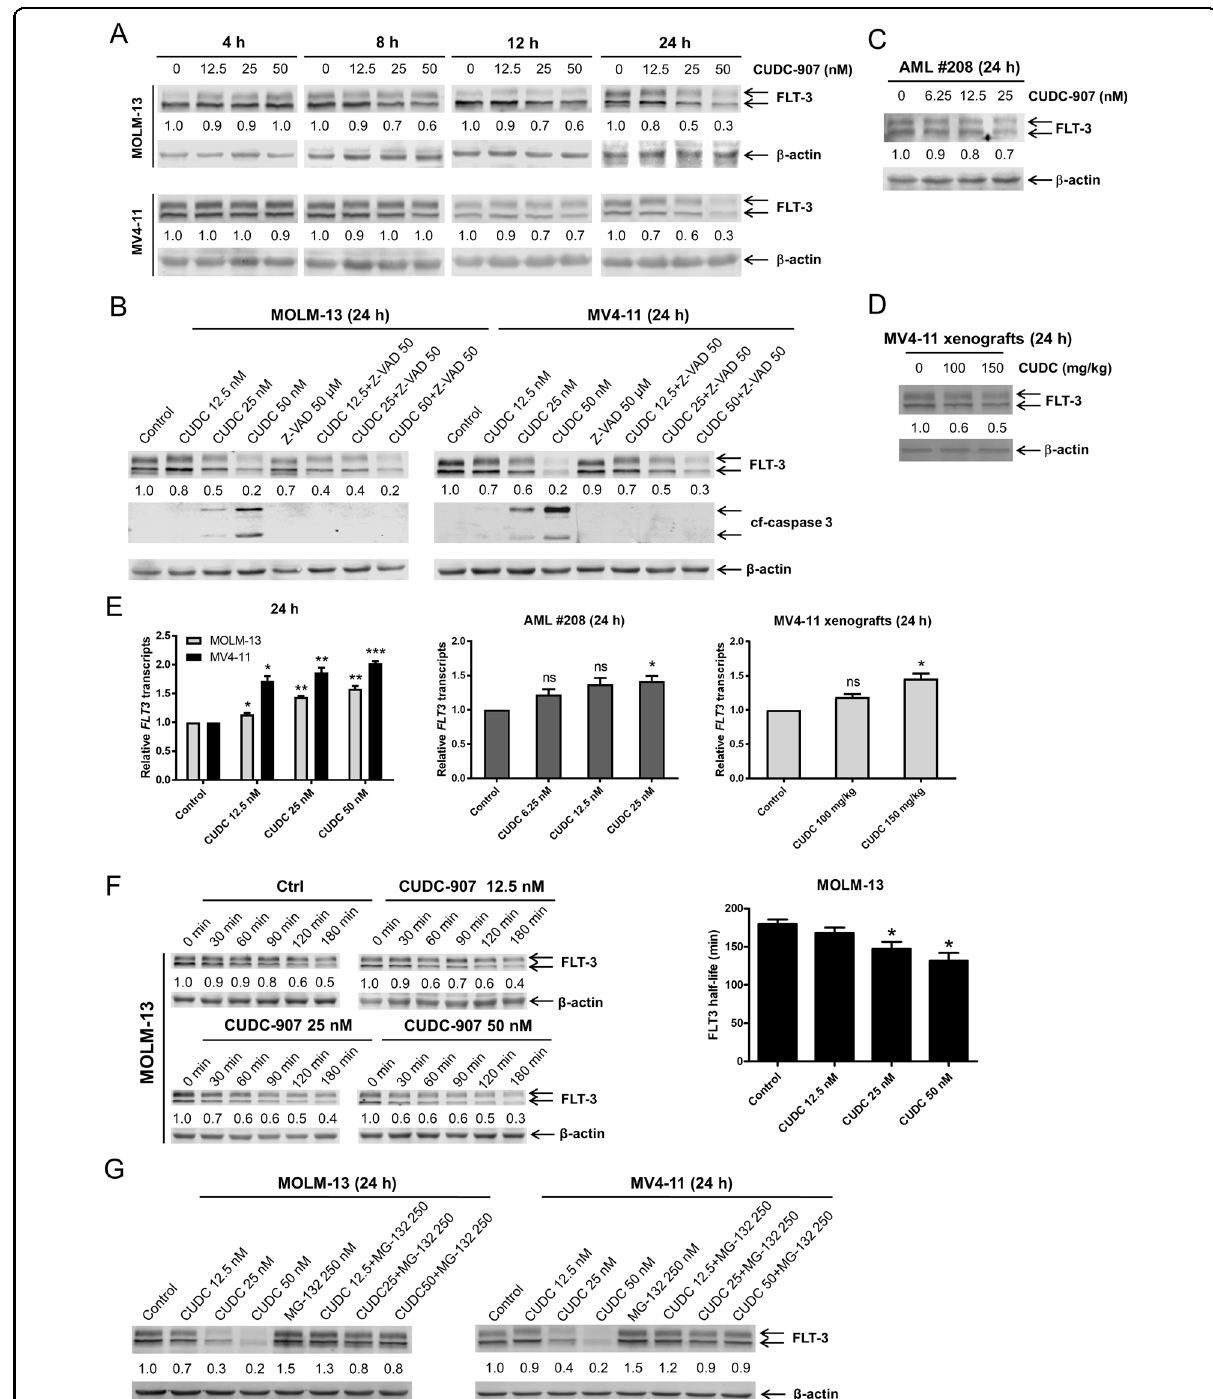
Fig. 1 (See legend on next